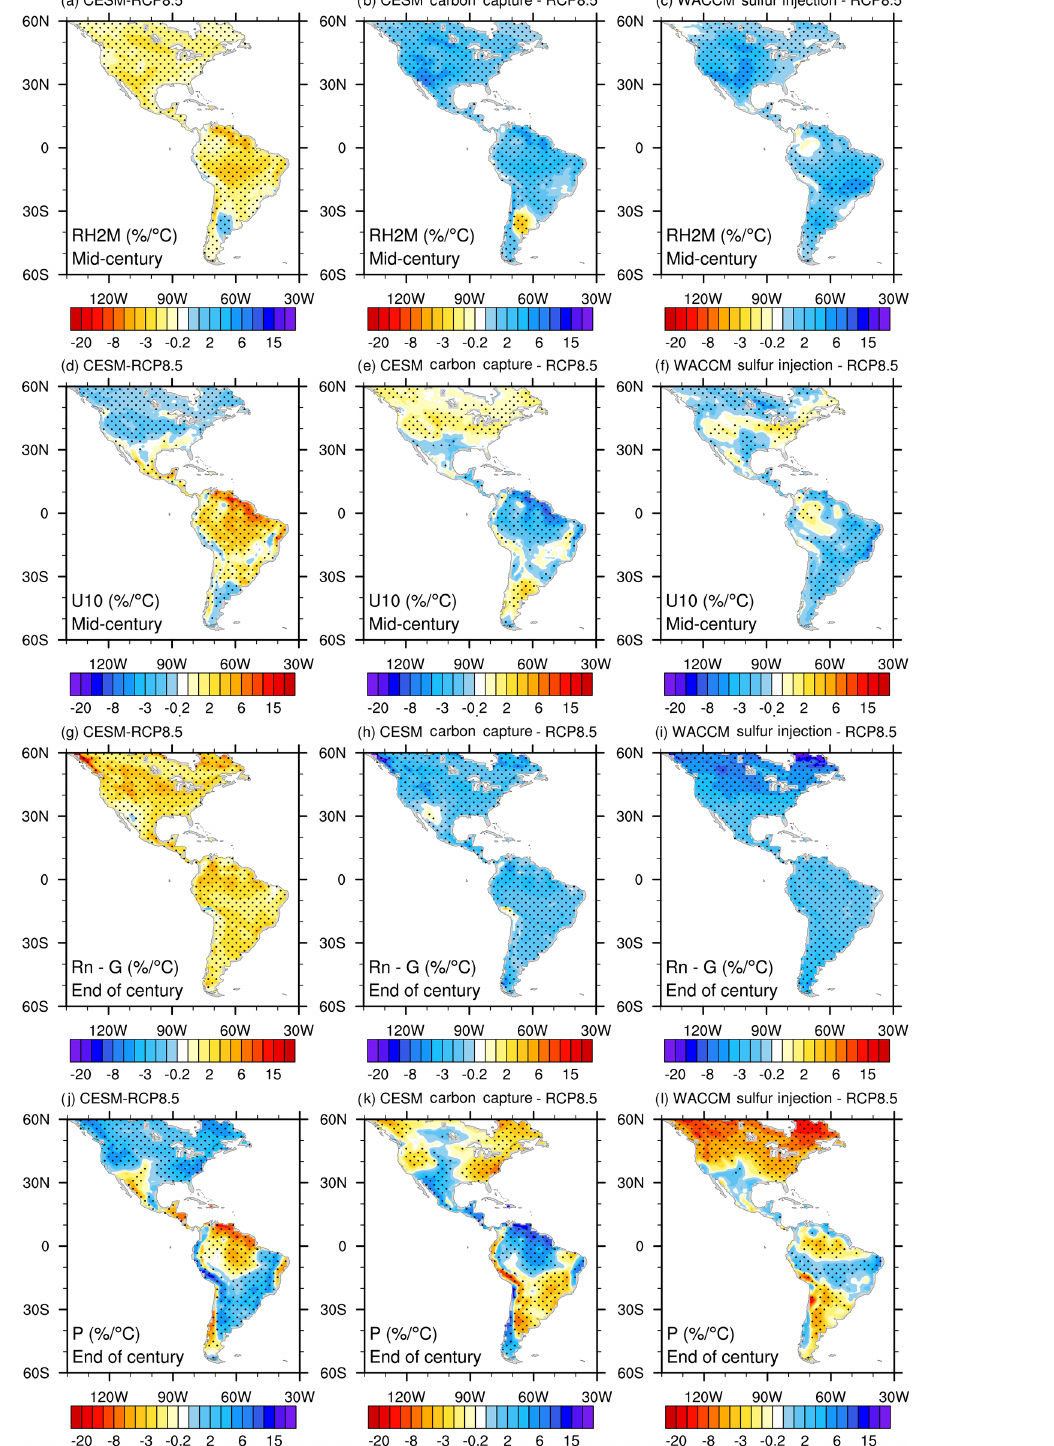
Figure 10. Similar to Fig. 8 but showing RH2M (row 1; relative humidity, normalized change in percent per degree Celsius), U 10 (row 2; surface wind, normalized change in percent per degree Celsius), Rn-G (row 3; surface-available energy, normalized change in percent per degree Celsius), and P (row 4; precipitation, normalized change in percent per degree Celsius). Left panels show the changes in baseline warming. Middle panels show mitigated change due to carbon capture. Right panels show the mitigated change due to sulfur injection. Note that, for simplicity, we only show RH2M and U 10 results for the mid-century, as well as Rn-G and P results for the end of the